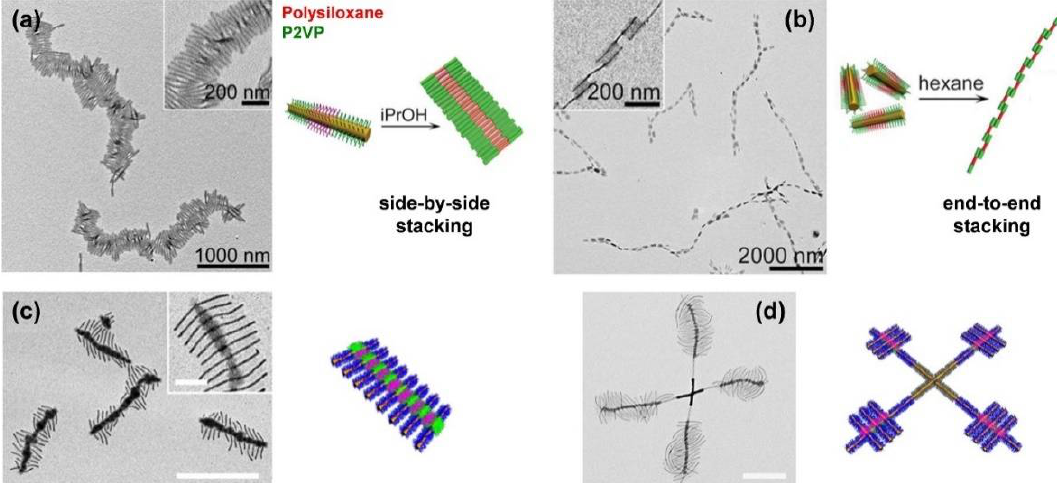
Figure 4. One-dimensional supermicelles by ( a ) side-by-side and ( b ) end-to-end stacking in selective solvents for the outer and middle corona block of B–A–B triblock co-micelles (PFS core), respectively. ( c ) “Shish-kebab” supermicelles (scale bar = 1 µ m, inset = 200 nm) formed by hydrogen-bond (H-bond)-mediated co-assembly of an H-bond donor homopolymer (hydroxyl-functionalized poly(vinylmethylsiloxane (PMVSOH), colored in pink) with B–A–B triblock co-micelles with “neutral” outer corona blocks (poly( t -butyl acrylate) (P t BA), colored in blue, no H-bond interactions) and an H-bond acceptor middle corona block (P2VP, colored in green). ( d ) “Windmill”-like supermicelles via living CDSA of a PFS- b -P t BA diblock copolymer from “cross” supermicelles (scale bar = 0.5 µ m). The “cross” supermicelles featured an H-bond acceptor corona block (P2VP) at the termini, onto which short CCMs with H-bond donor corona blocks (PMVSOH) that served as seeds for the subsequent living CDSA of the PFS- b -P t BA diblock copolymer (color code identical to ( c )) were immobilized. ( a , b ) reproduced from [88] with permission of AAAS, ( c ) reproduced from [133] with permission of ACS, and ( d ) from [132] with permission of Springer